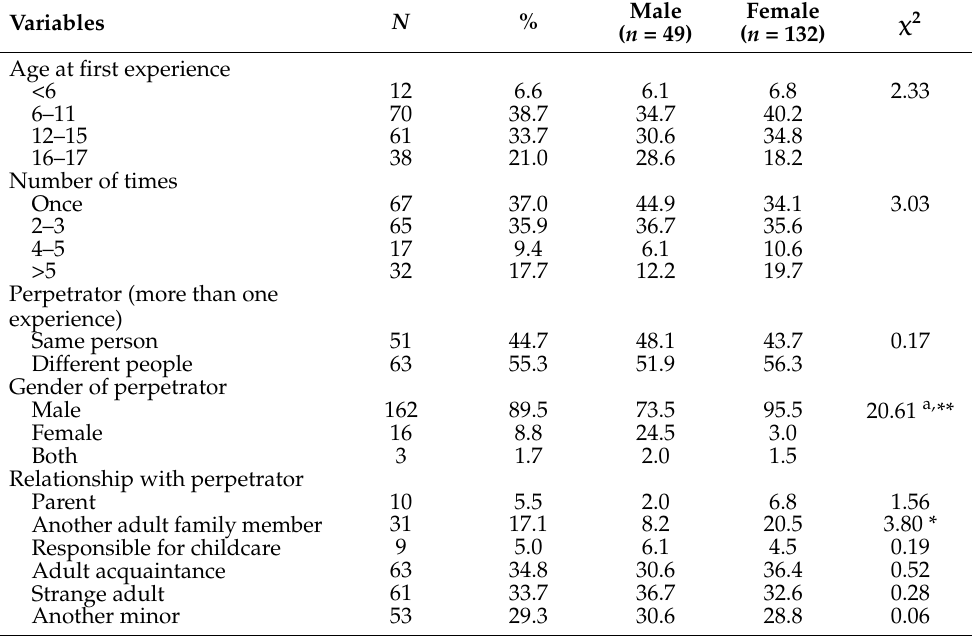
Table 2. Percentage of victims’ age at the first experience and perpetrator’s characteristics as a function of gender for “somebody fondled some part of my